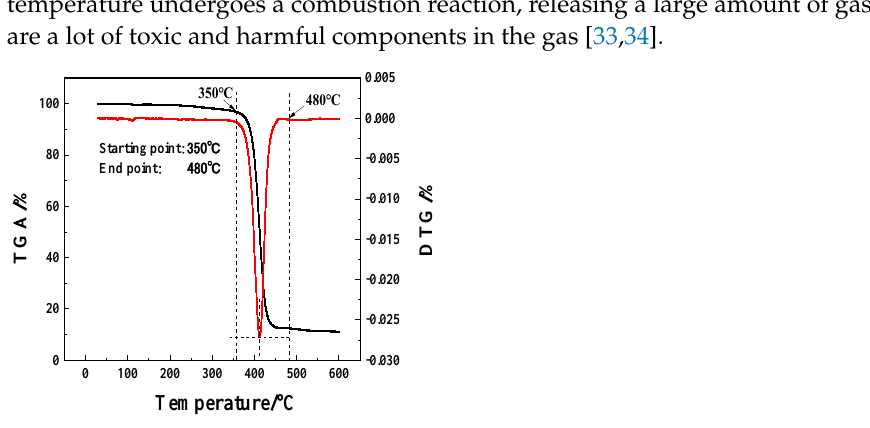
Figure 4. Thermal pyrolysis analysis chart of thermal insulation material. Table 1. Thermal mass-loss table. Table 1. Thermal mass-loss table.